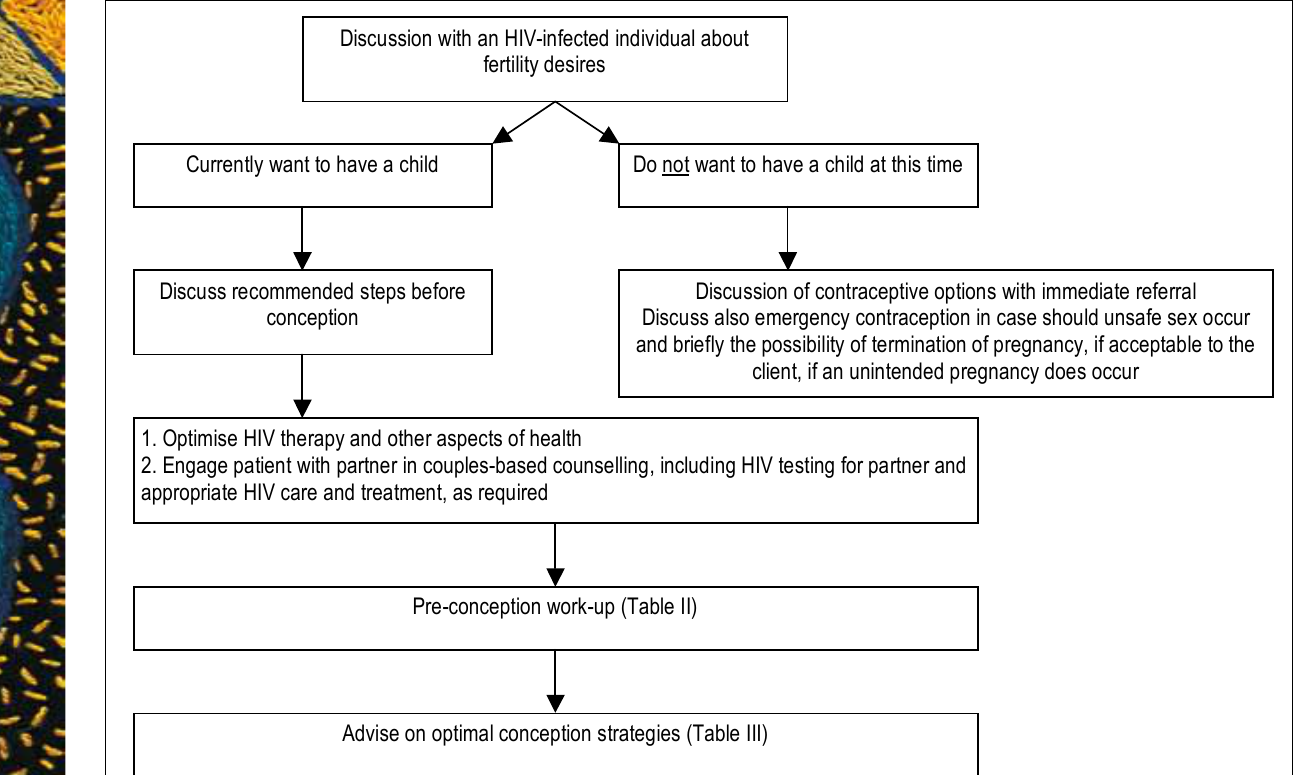
Fig. 1. Flow diagram to approach pregnancy-related issues in HIV-infected women and